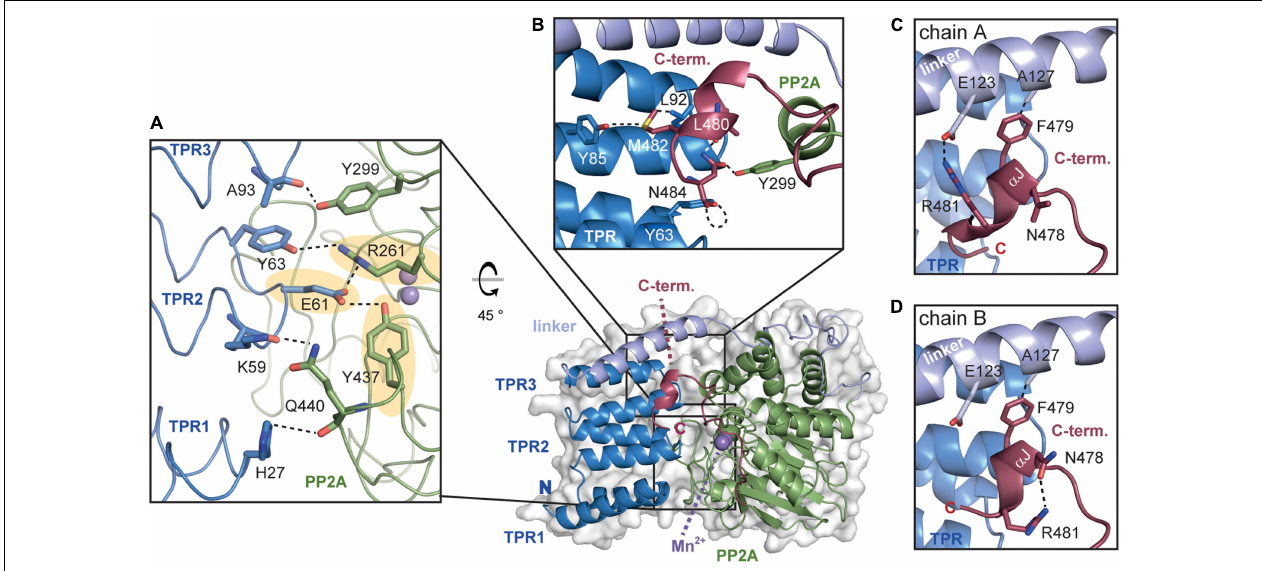
FIGURE 5 | The TPR-PP2A interface of At PAPP5. (A) The inhibition of the PP2A domain by the TPR region is based on a variety of direct interactions. The hydrogen bonds from E61 to R261 and Y437 (highlighted in yellow), which are also involved in phosphate binding, are depicted in dashed lines. (B) The C-terminal helical segment interacts with both the TPR and the PP2A domain. The hydrogen bonding network between C-terminal inhibitory motif and TPR2 as well as the PP2A domain is indicated with dashed lines. (C,D) The interactions of the C-terminal helical segment differ between chains A and B. The interactions of the amino acids are represented by dashed black